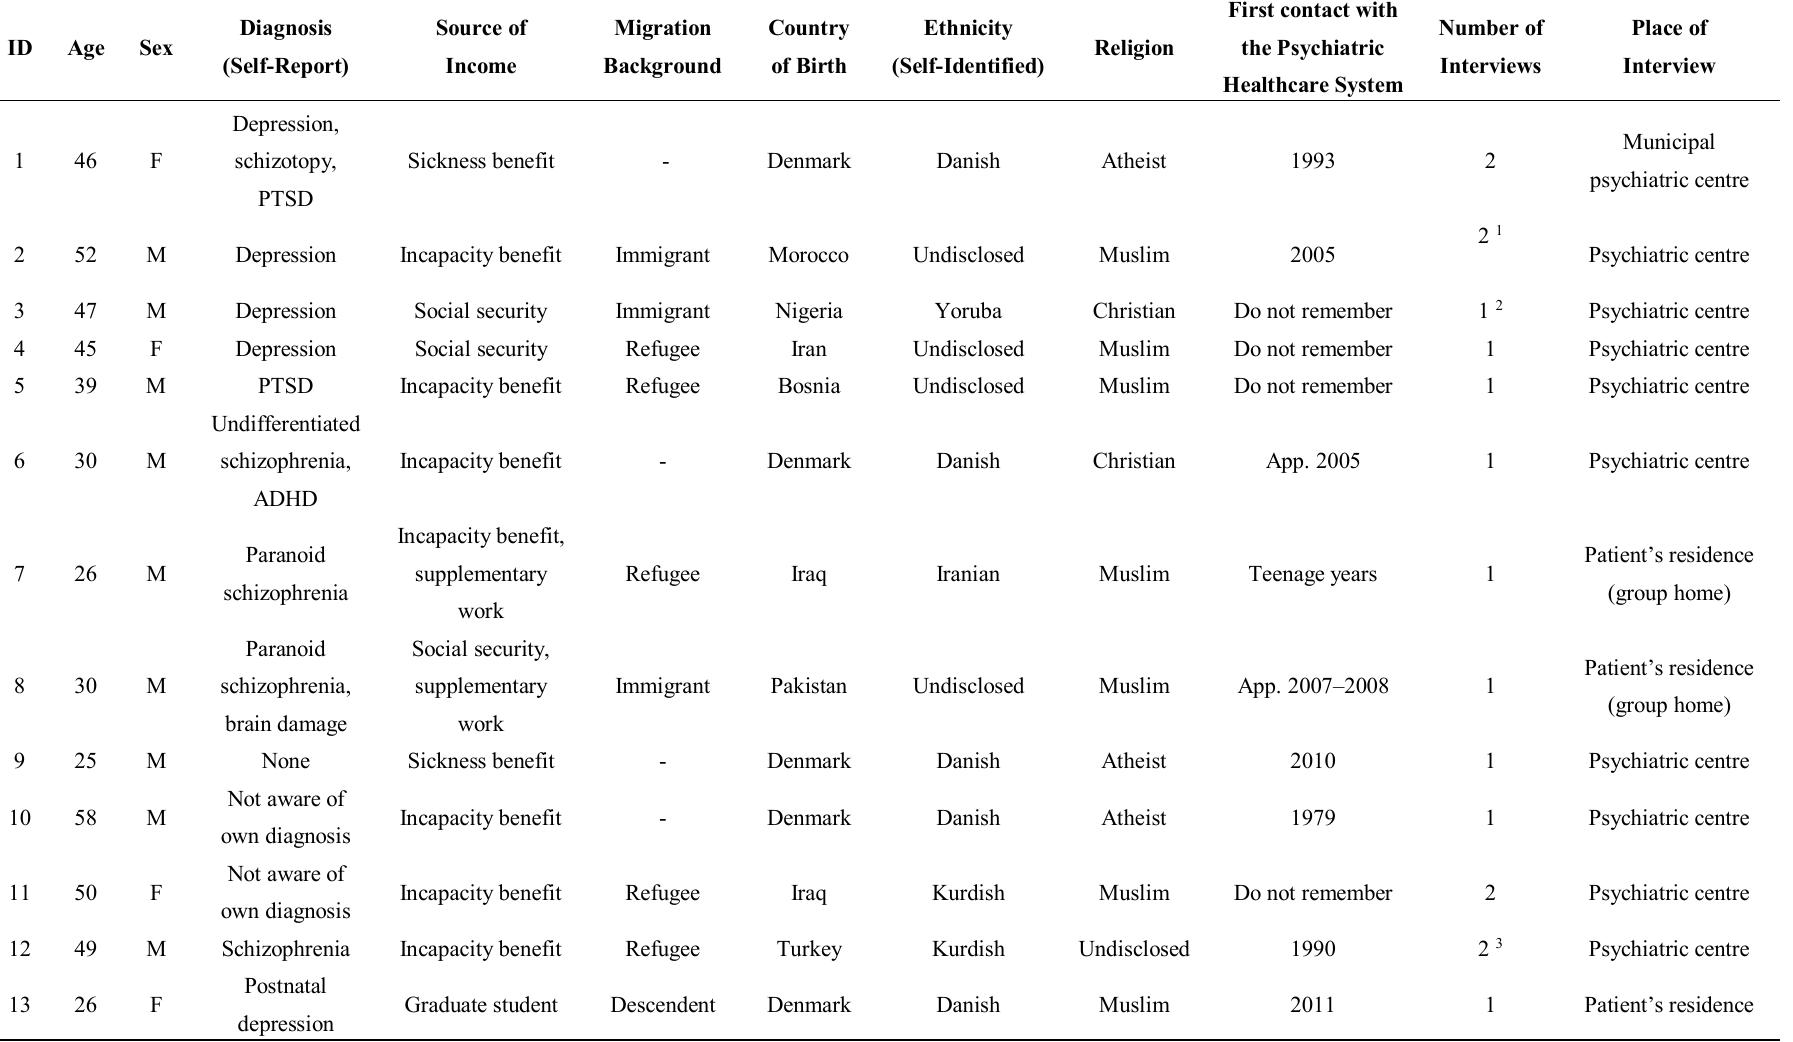
Table 1. Characteristics of participants in the